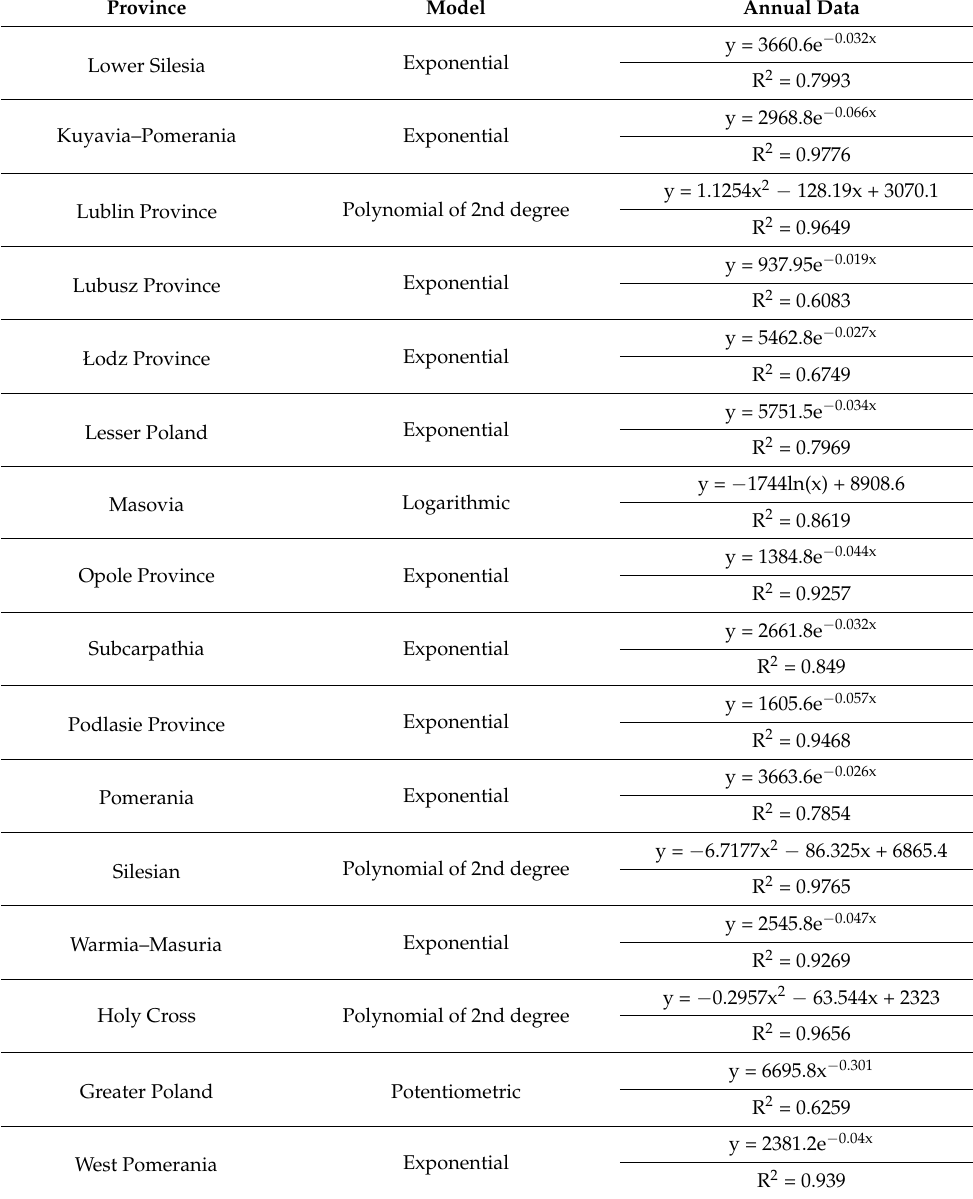
Table 2. Best trend models for annual